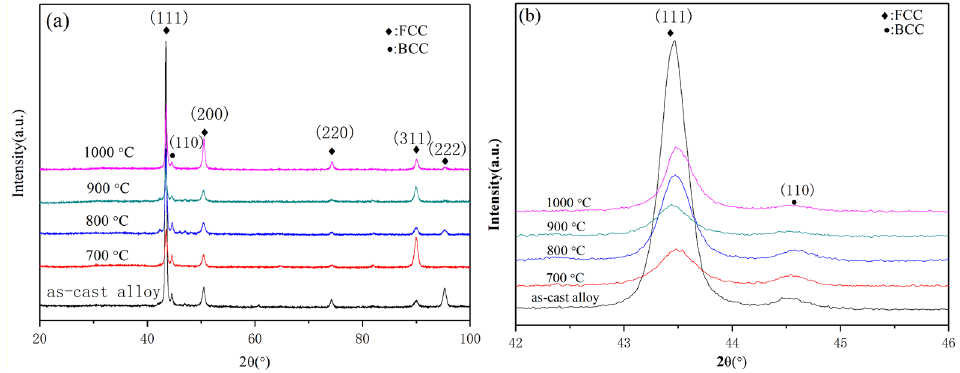
Figure 1. XRD patterns of (FeNi)67Cr15Mn10Al5Ti3 HEA. ( a ) Diffraction pattern of 2θ between 20° and 100°. ( b ) (111) Enlarged view of crystal plane.